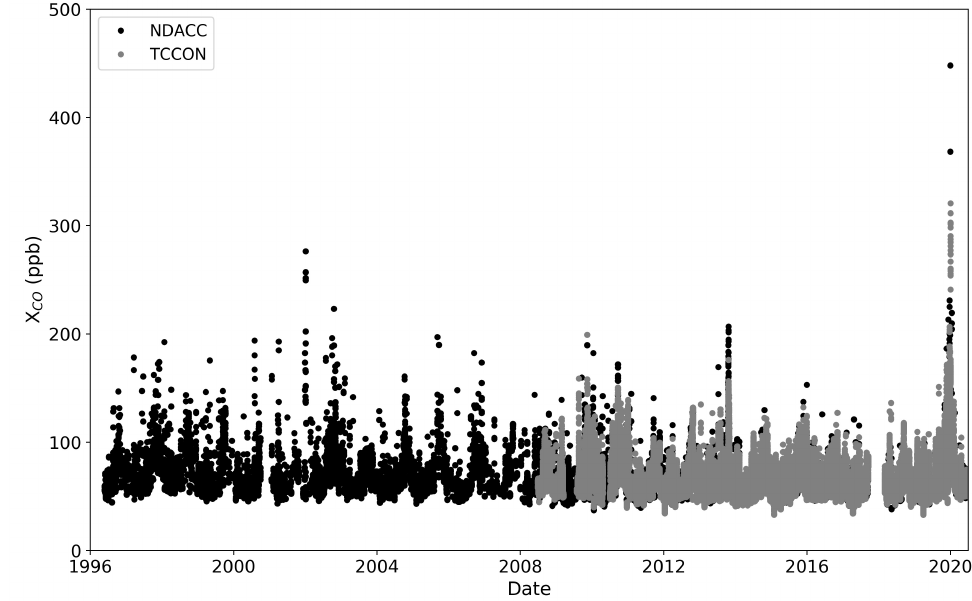
Figure 4. Time series of long term column CO data record in Wollongong from NDACC (from May 1996) and TCCON (from July 2008–June